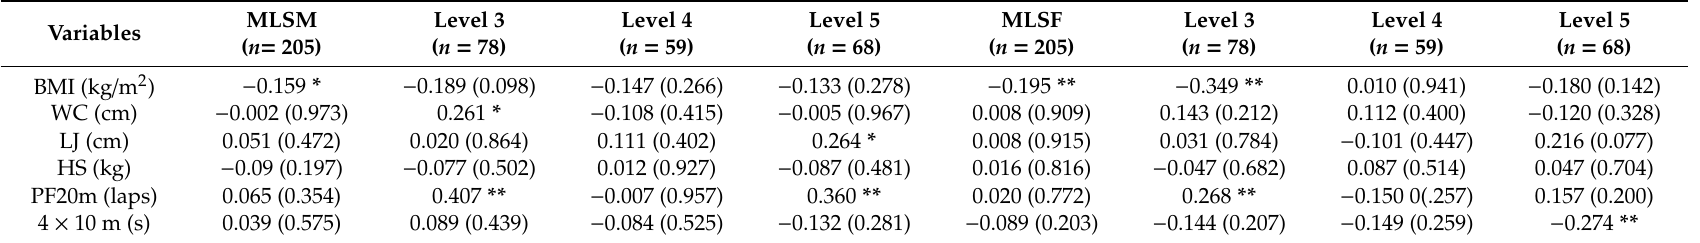
Table 4. Correlations between PREFIT physical fitness and maximum level of studies of the mother and father by